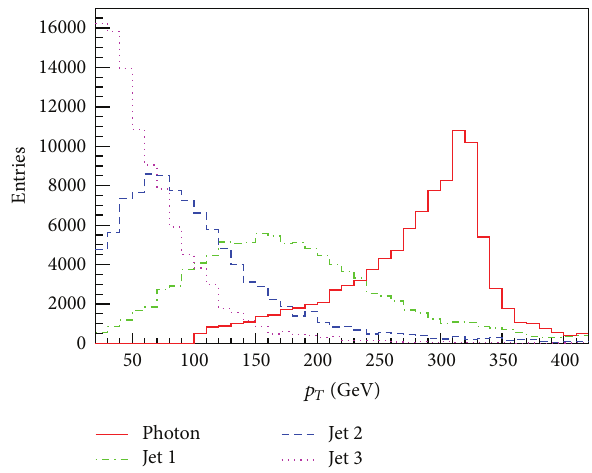
Figure 9: Transverse momentum distributions of leading jet (Jet 1) and other jets (Jet 2 and Jet 3) and photon for signal ( 𝑡𝛾 production) after detector simulation.